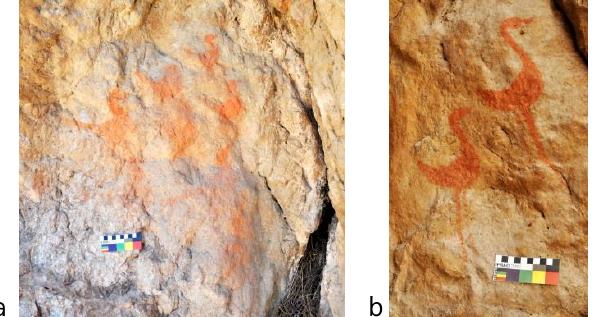
Figure 9. Kuh-e-Donbeh, Site IV. Water birds.